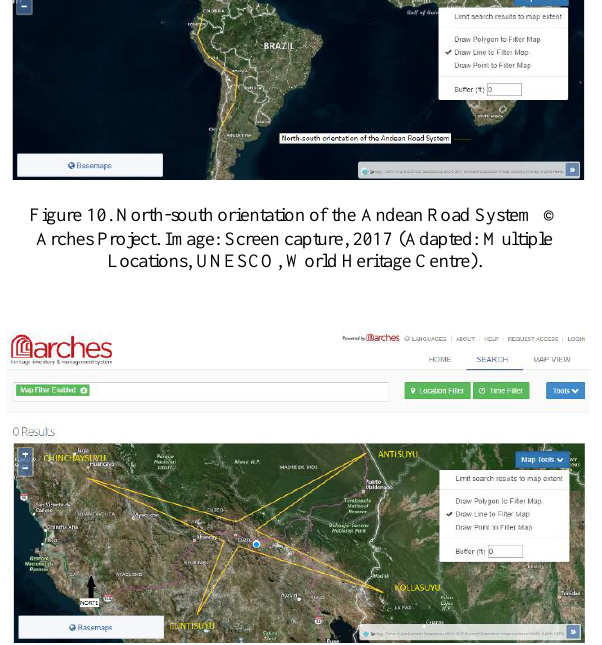
Figure 11. Radial system of zeq'e (lines) of Cusco © Arches Project. Image: Screen capture, 2017 (Adapted de Bauer in D´Altroy, 2003, Los Incas . p. 195. Ariel Pueblos,